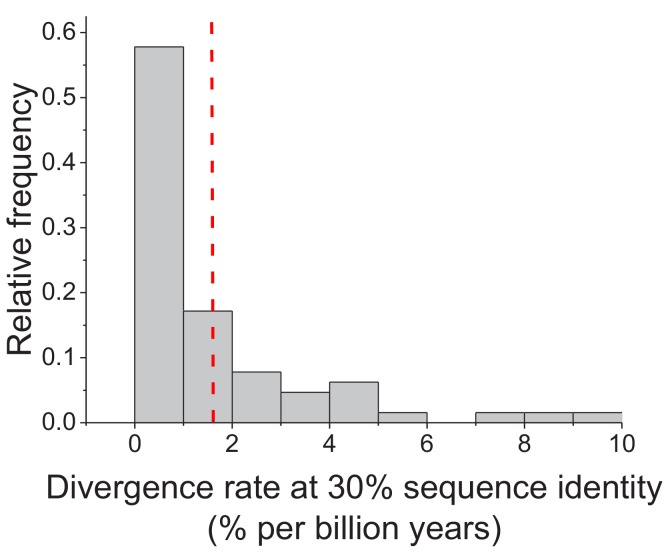
Enzyme divergence rates at 30% sequence identity.The distribution of sequence divergence rates between orthologous enzymes when their sequence identity reaches 30%. Divergence rates were defined as the decrease in percent sequence identity per billion years. Divergence rates were calculated based on the Model 3 fits and Equation 4. The dashed red line represents the mean value of the distribution across enzymes (1.6% per billion years).